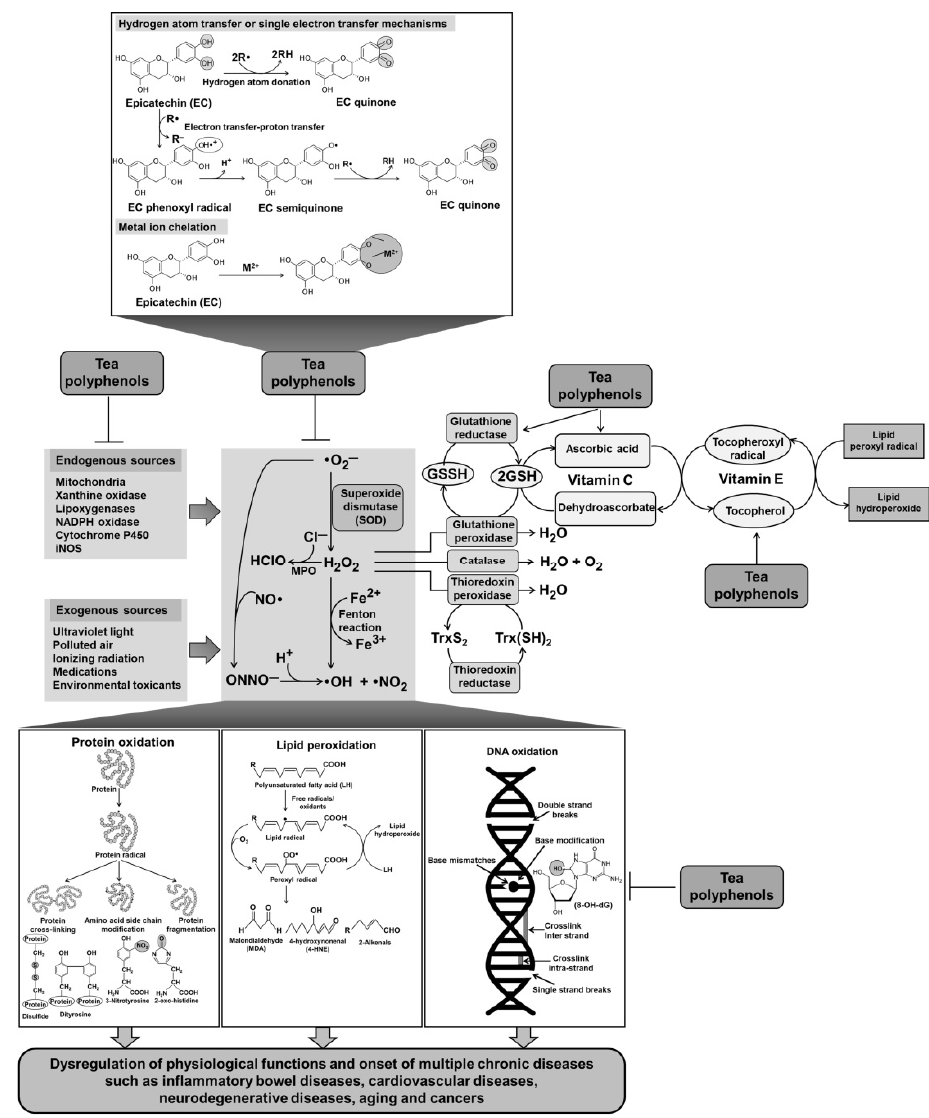
Figure 2. Scheme showing ROS/RNS formation and possible antioxidant mechanisms of tea polyphenols. ROS/RNS can be produced by endogenous sources (e.g., mitochondria, xanthine oxidase, lipoxygenase, NADPH oxidase, cytochrome P450, and inducible nitric oxide synthase) and exogenous sources (e.g., ultraviolet light, polluted air, ionizing radiation, medications, and environmental toxicants). Under normal conditions, ROS/RNS are scavenged and neutralized by intracellular antioxidant defense systems, including enzymatic antioxidants (e.g., superoxide dismutase, catalase, glutathione peroxidase, and thioredoxin peroxidase) and nonenzymatic antioxidants (e.g., vitamin C and vitamin E). However, oxidative/nitrosative stress is associated with an overproduction of ROS/RNS that attacks cellular biomolecules such as proteins, lipids, and DNA, thereby resulting in the dysregulation of normal physiological functions and the onset of multiple chronic disorders such as cardiovascular diseases, inflammatory bowel diseases, and cancers. Tea polyphenols can inhibit ROS/RNS formation, scavenge and neutralize radicals and oxidants, upregulate intracellular antioxidant defense systems, and suppress oxidative/nitrosative biomolecule damages, thereby preventing the development of diseases. MPO, Myeloperoxidase; iNOS, Inducible nitric oxide